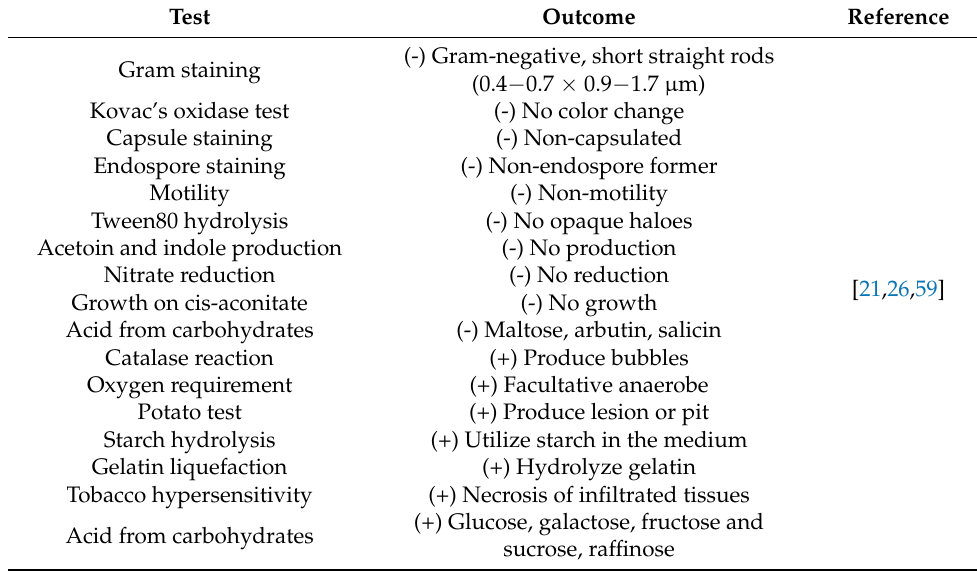
Table 1. Phenotypic characterization P. stewartii subsp. stewartii